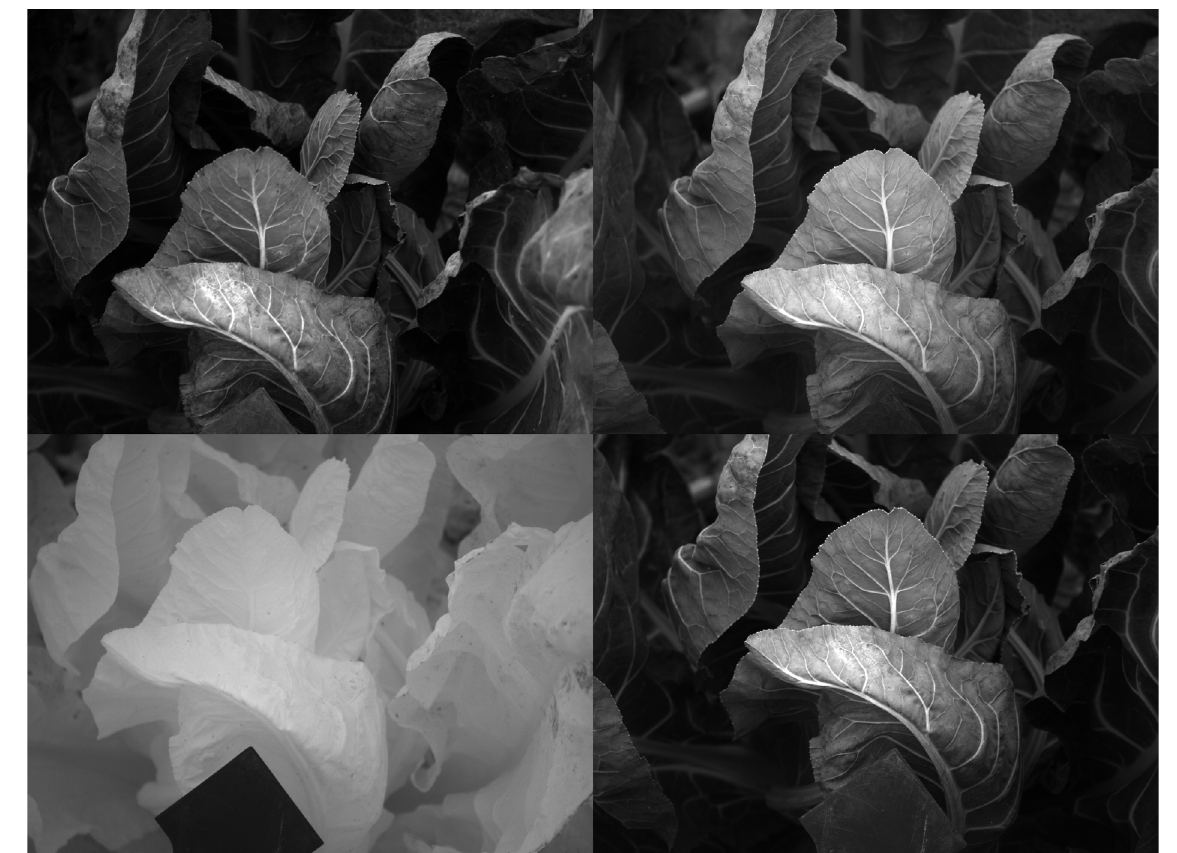
Figure 3. Agroscanner sample measurement from 4 spectral cameras—each spectral resolution 1400 × 1200 pixels, spectral lengths: 470, 550, 850 and 640. 1400 × 1200 pixels, spectral lengths: 470, 550, 850 and